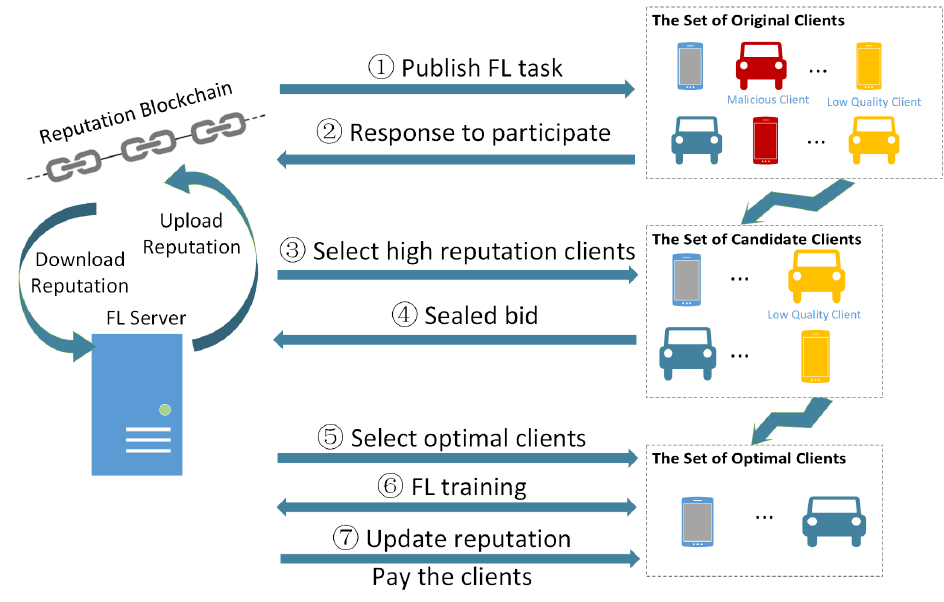
Figure 1. The workflow of the incentive